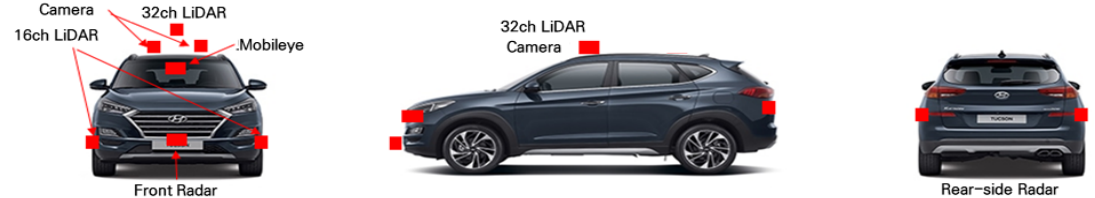
Figure 4. Configuration of the data gathering facility (automated vehicle).